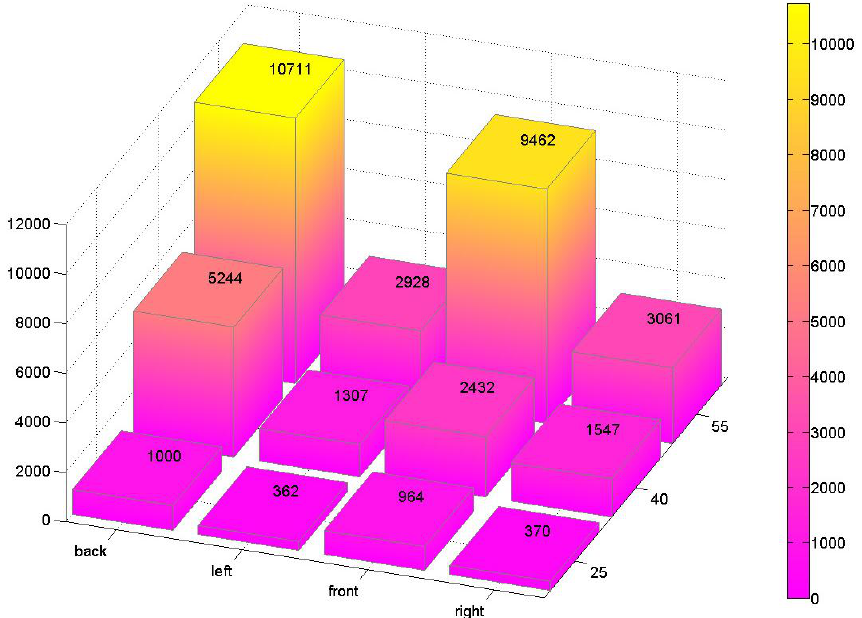
Figure 5. Head injury criterion (HIC) at different collision parameters.